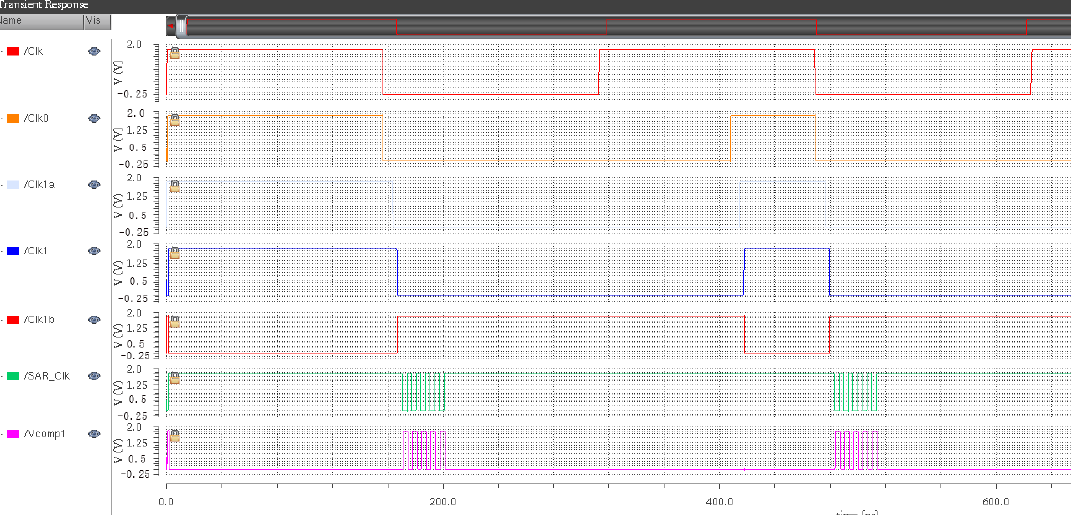
Figure 9. Simulation diagram of the overall clock of the quantization part.